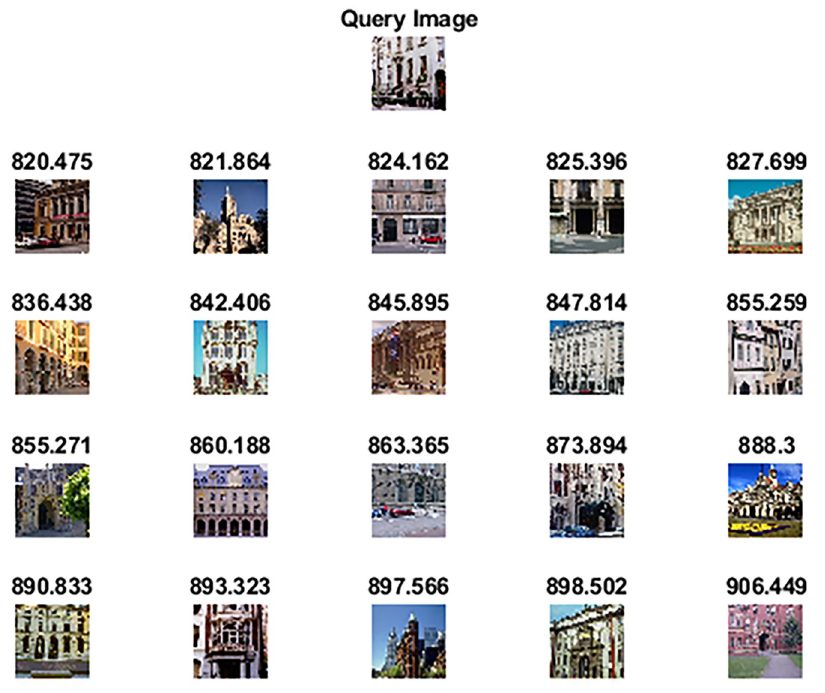
Fig 17. Top-20 retrieved images according to the query image of the OT Scene dataset (class: inside a city).